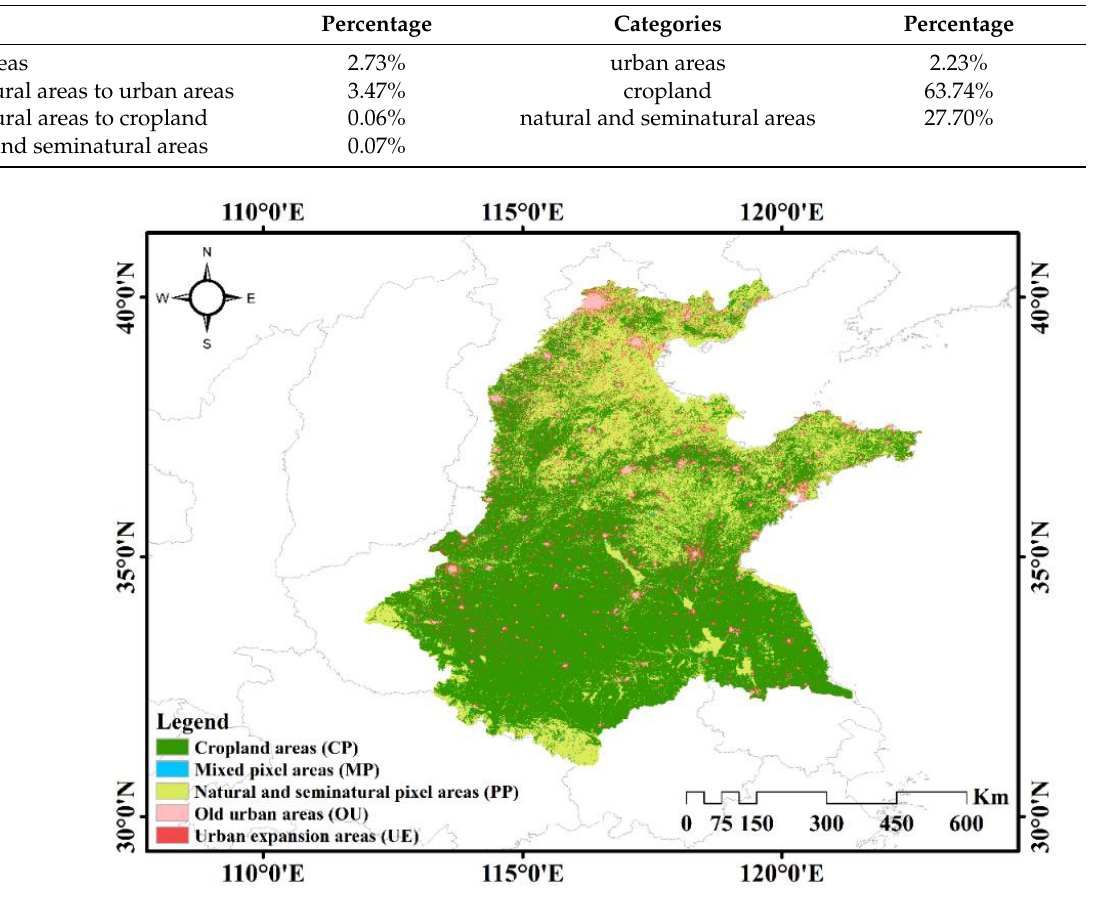
Figure 2. Spatial distribution of land use types in the Huang-Huai-Hai River Basin in 2015.